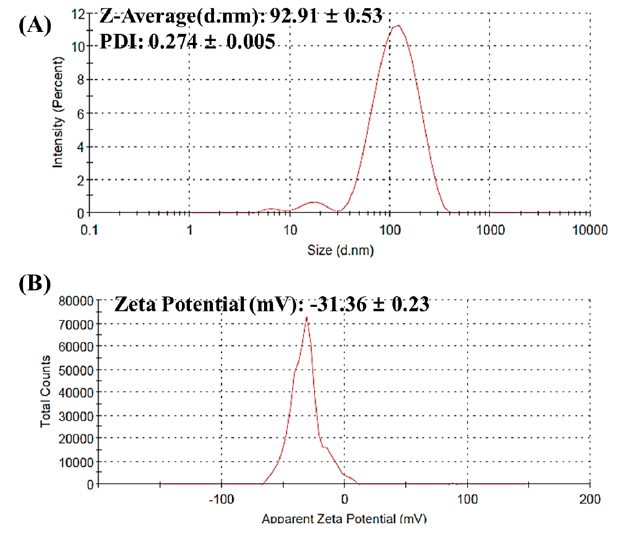
Figure 3. Zeta size analysis. Hydrodynamic particles size of Qn-AgNPs ( A ); and zeta potential of Qn-AgNPs ( B ).